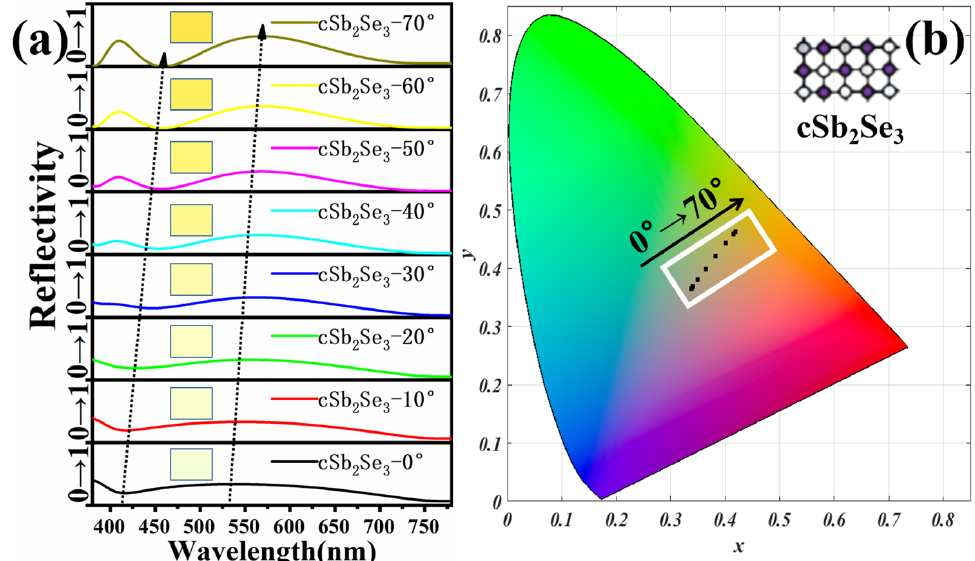
Figure 7. ( a ) Reflectivity spectra and corresponding colors of different incidence angles under cSb 2 Se 3 state; ( b ) color coordinates corresponding to different incidence angles on the chromaticity diagram under cSb 2 Se 3 state.